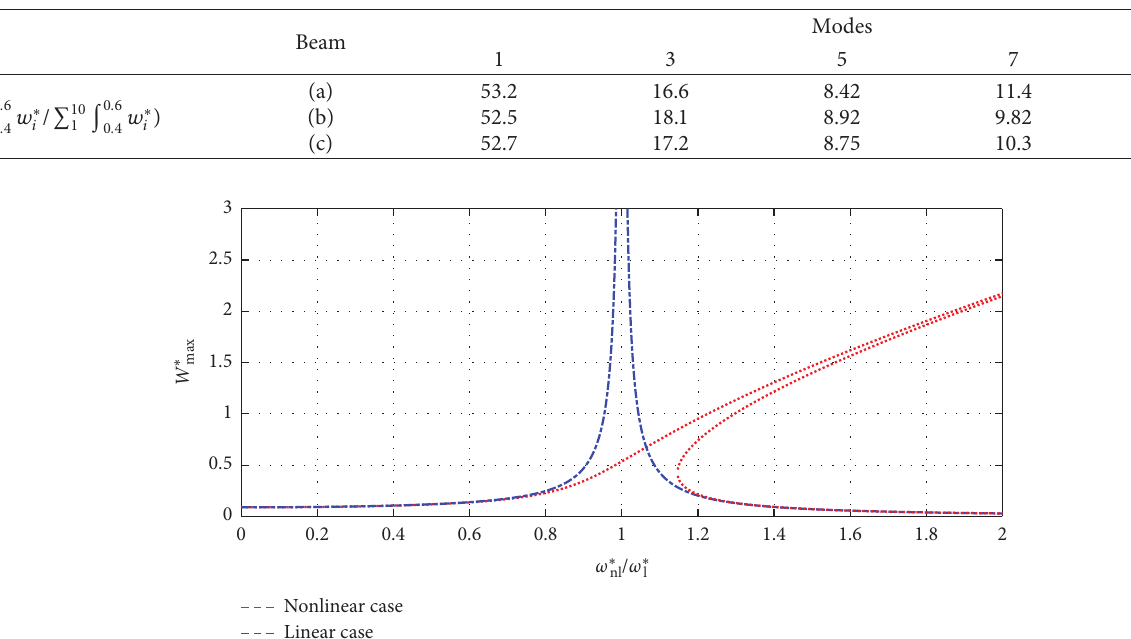
Figure 10: Backbone curves of beam (b) in the vicinity of the first mode for various values of R Table 11: Percentage of generalized forces exciting the first five symmetric modes of three types of beams excited by a uniformly distributed force over an interval of [0.4, 0.6].